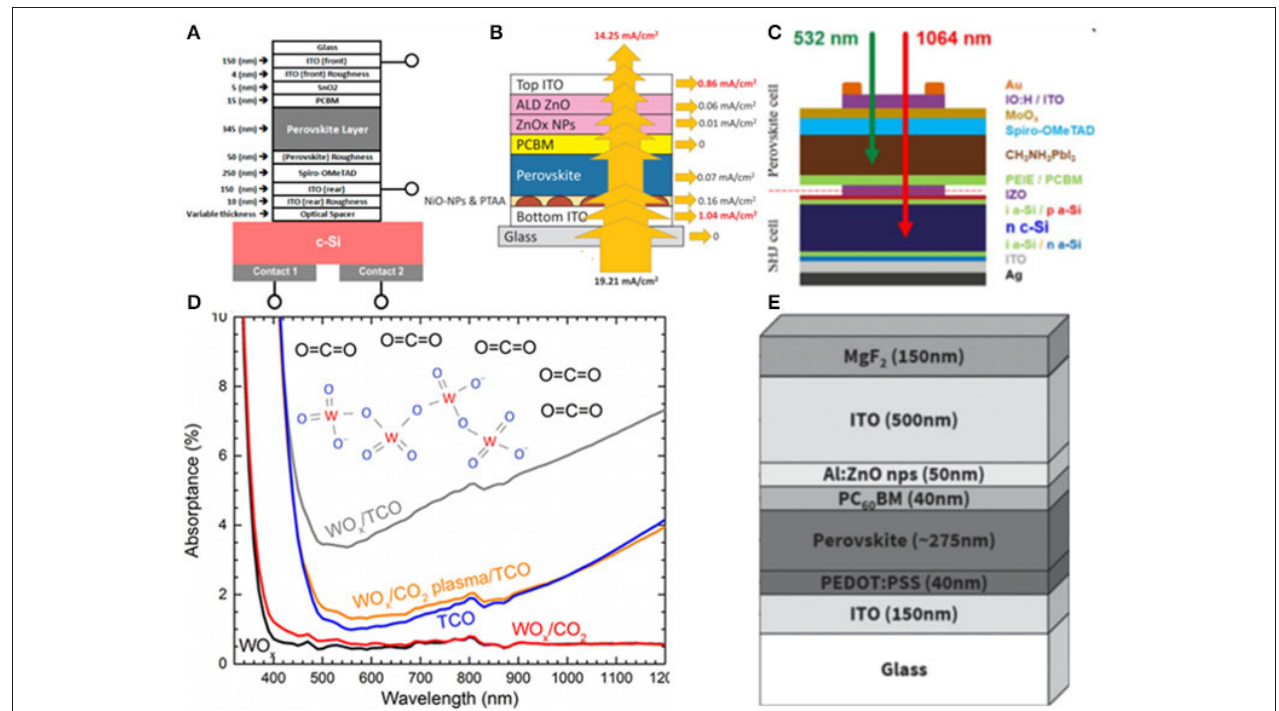
FIGURE 1 | (A) Device structures of the 2T PVSK/Si tandem solar cell (reproduced from ref. 19, copyright 2017, Nature Energy). (B) Detailed optical loss analysis of ST-PSCs in NIR (800–1,200nm). ITO layer thickness is set at 140nm (reproduced from ref. 20, copyright 2018, Elsevier). (C) Schematic of the monolithic PVSK/Si tandem cells (reproduced from ref. 10, copyright 2016, ACS). (D) Absorption spectra and tauc plots of ∼ 10 nm-thick evaporated MoO x , WO x , and V 2 O x layers on glass (reproduced from ref. 21, copyright 2016, ACS). (E) Illustrative schematic of the device architecture showing the ITO electrode encapsulation layer (reproduced from ref. 22, copyright 2016, Wiley VCH).